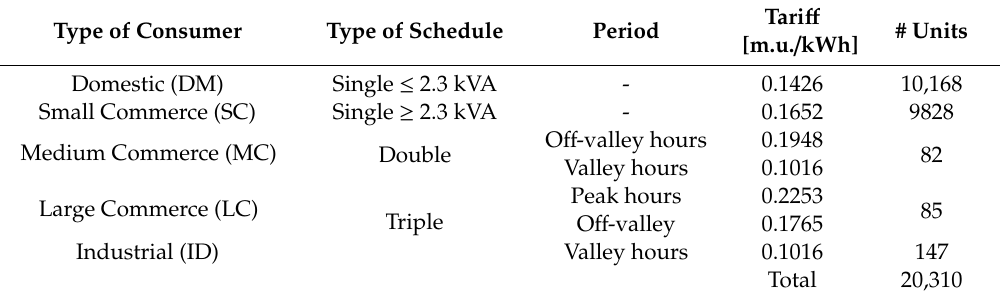
Table 2. Consumers’